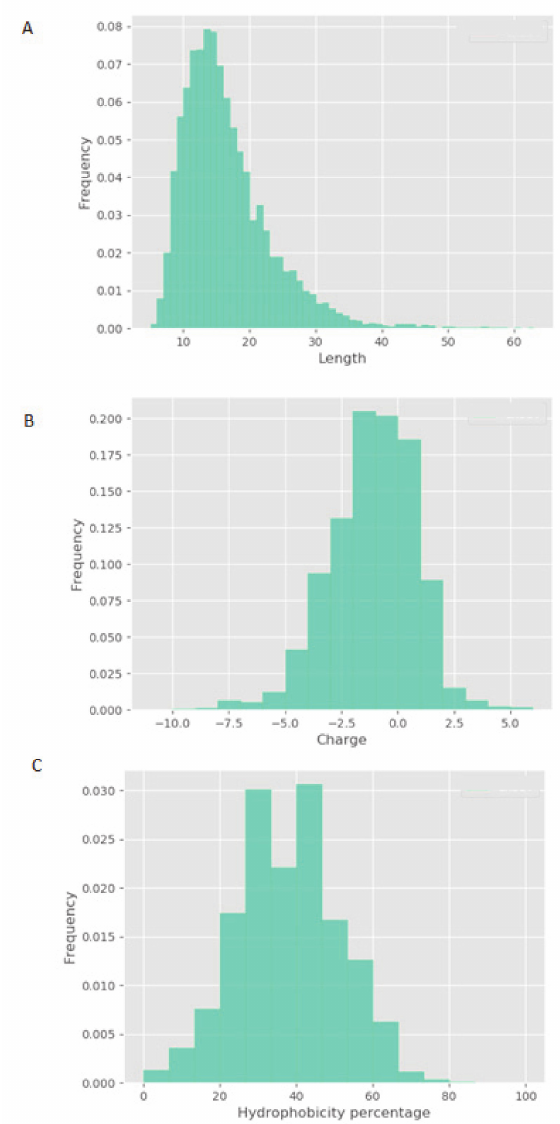
Figure 2. Physicochemical properties of the NPN_1 peptide profile as determined by LC-MS / MS. Histogram representation of the NPN_1 peptide distribution according to ( a ) length, ( b ) charge, and ( c ) percentage hydrophobicity; peptide counts are displayed on the